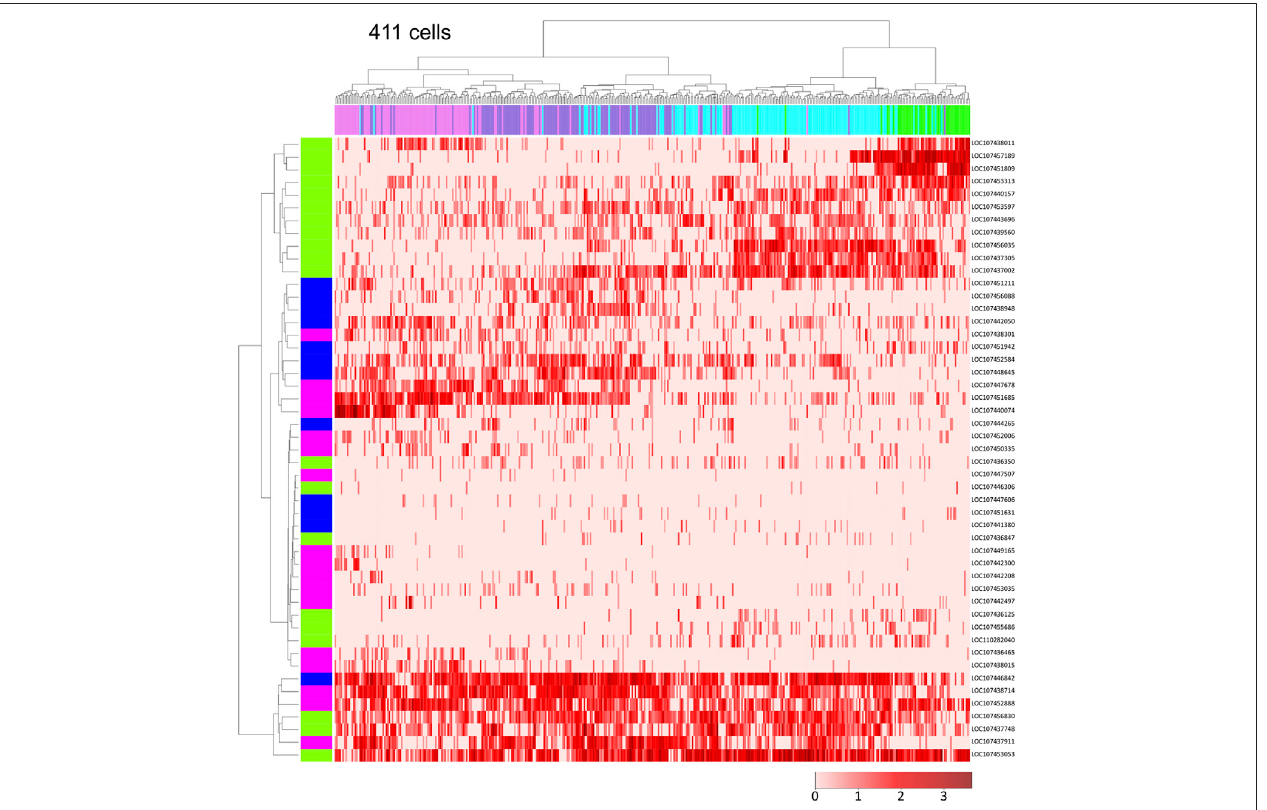
FIGURE 3 | Single-cell transcriptome data showing global polarization of presumptive ectodermal cells. Dendrograms of 411 presumptive ectodermal cells (top) and Pt-hh and 48 genes regulated by Hh signaling (left) were constructed by hierarchical clustering of the normalized expression level of each gene in each cell. The bar on the top displays the cluster of the cells shown in Figure 2A : green, cluster 2; light blue, cluster 3; purple, cluster 4; magenta, cluster 5. The bar on the left shows the expression domain of genes in the germ disc revealed by WISH: green, peripheral region; blue, intermediate region; pink, central region. The heatmap shows the normalized expression levels of genes in the cells (The color code in the bottom